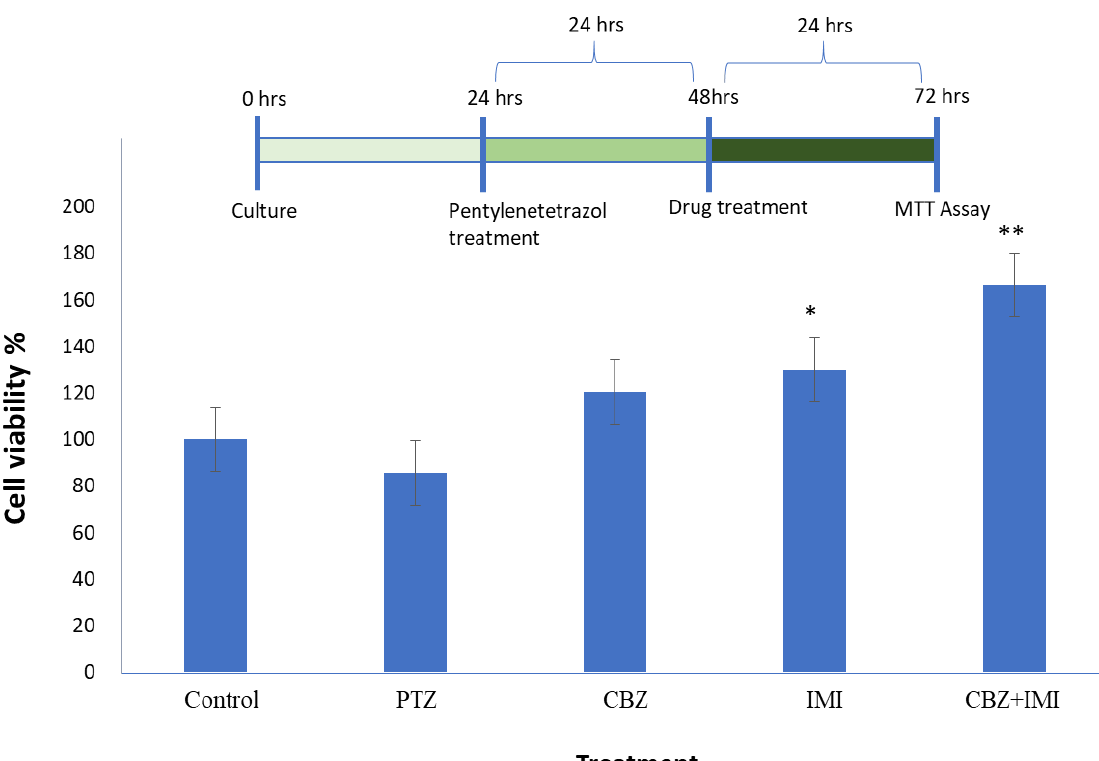
Figure 8. Cell viability assay by MTT: HEK-293 cells treated with vehicle (Control group), PTZ (0.6 µ g/mL), CBZ (0.35 µ g/mL), IMI (0.35 µ g/mL), CBZ + IMI (0.70 µ g/mL + 0.35 µ g/mL). The cells were first treated with PTZ for 24 h, then exposed with CBZ, IMI, CBZ + IMI for 24 h. The % of cell viability given in the graph is taken from the dose that gave the highest percentage of cell viability. The cells were exposed with doses ranging from 0.2 to 0.90 µ g/mL. The difference between the control and drug-treated groups was computed using ANOVA, p -values were computed by Student’s t -test; p < 0.05 *, p < 0.01 ** significance levels.